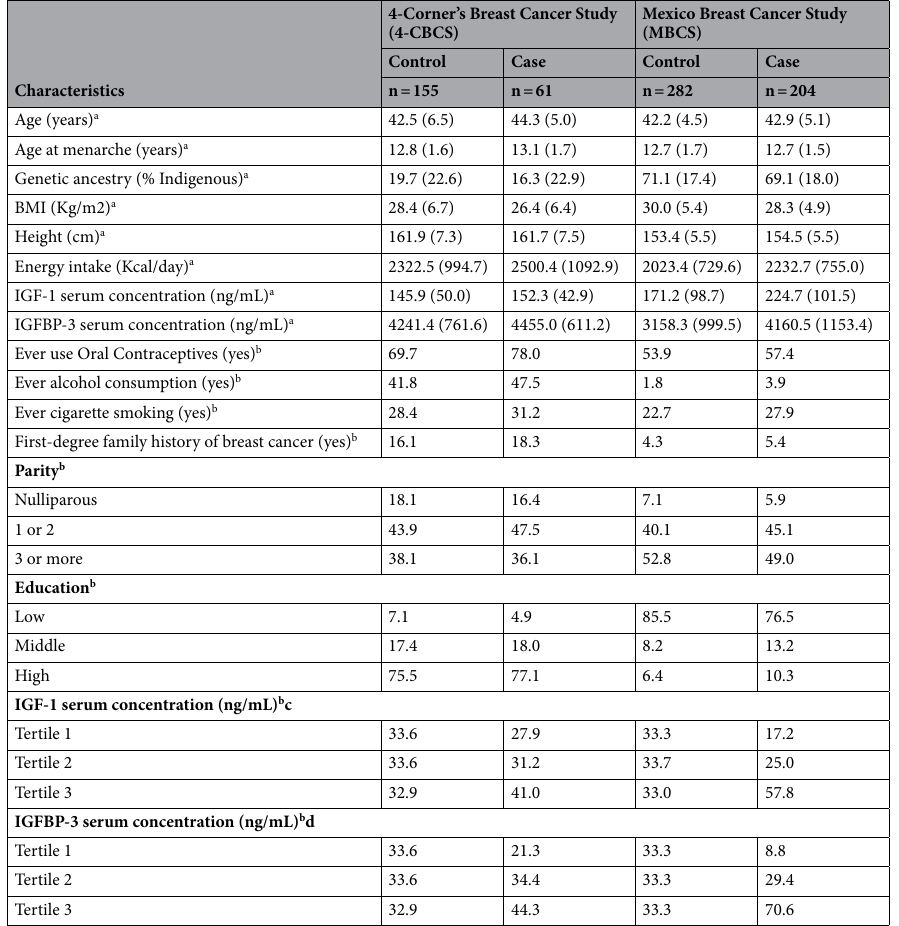
Table 1. Subject characteristics by study (premenopausal women), the Breast Cancer Health Disparities Study. a Mean and standard deviation (SD). b Percentage. c Cut points of tertiles of serum IGF-1 in 4-Corner’s Breast Cancer Study were (122.0, 161.0); in Mexico Breast Cancer Study (123.6, 200.7). d Cut points of tertiles